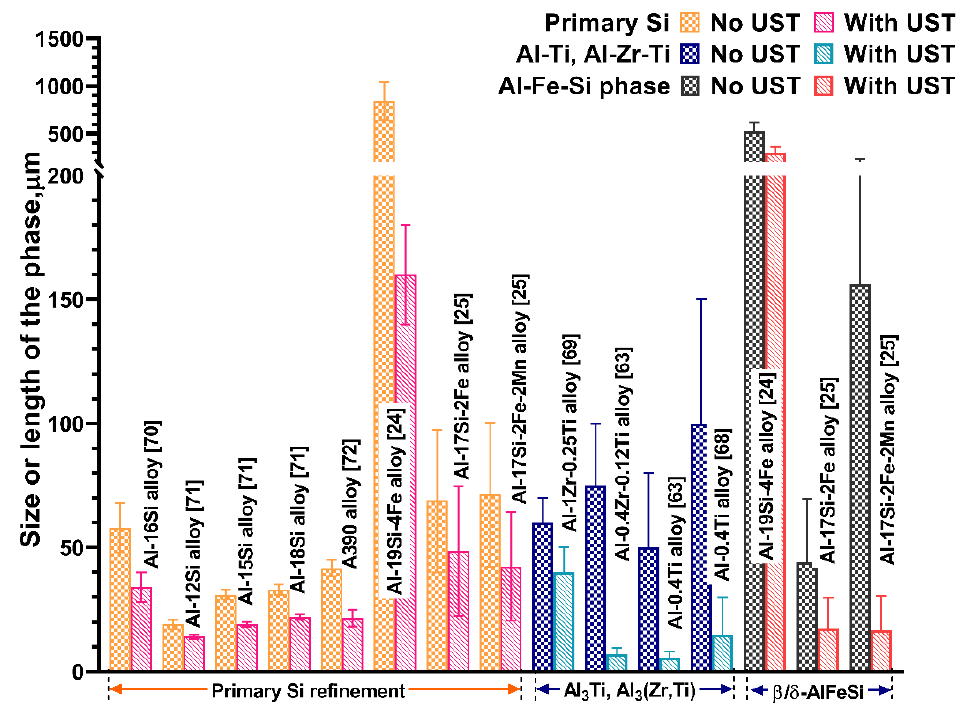
Figure 7. Refinement of primary intermetallic phases after UST reported for selected Al alloys.